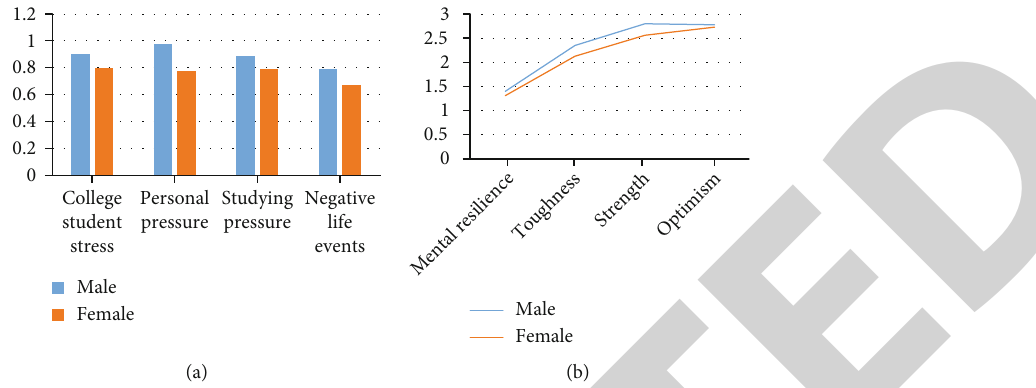
Figure 8: The test results of the di ff erence in psychological stress and psychological bombardment among college students of di ff erent genders.